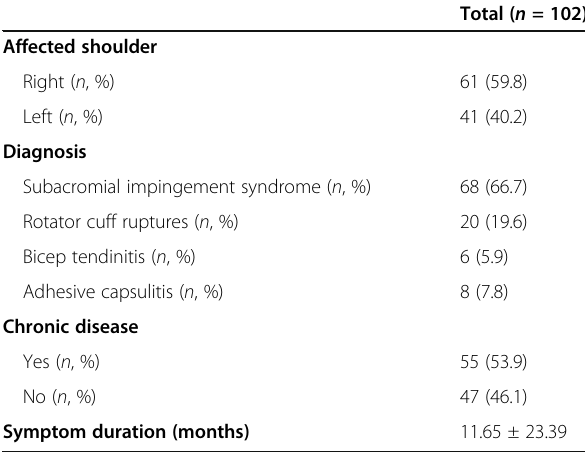
Table 2 Clinical data of the patients